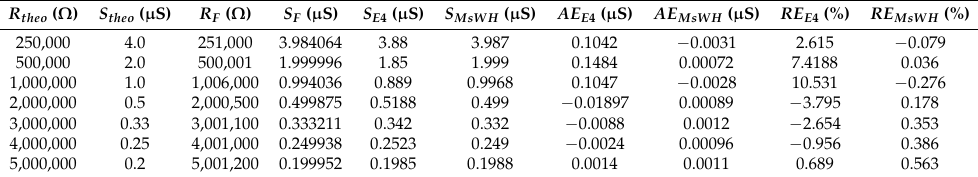
Table 3. EDA measurement. Conductance calibration. Experimental results. First column: Theoretical value of the resistance set. Second: related conductance values. Third: high-precision measurement of resistances. Fourth: related high-precision conductance values. Fifth and sixth: experimental conductance measurements through the E4 wristband and MsWH, respectively. Seventh and nineth: absolute and relative errors for the E4 wristband. Eighth and tenth: absolute and relative errors for the